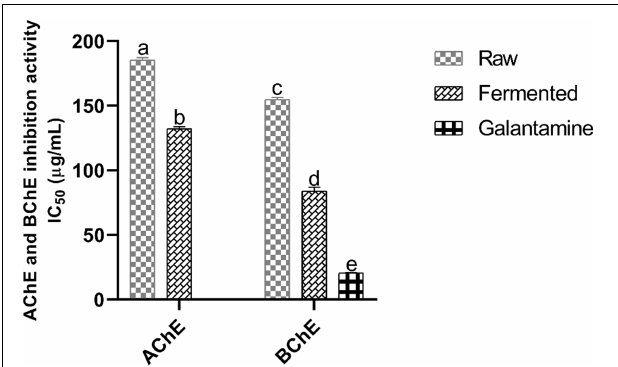
FIGURE 2 | Anticholinesterase activity ( in vitro ) of black soybean samples. Values represent triplicate readings IC50 ( µ g/mL) and different superscripts denote significant differences ( p < 0.05). AChE, acetylcholinesterase; BChE,